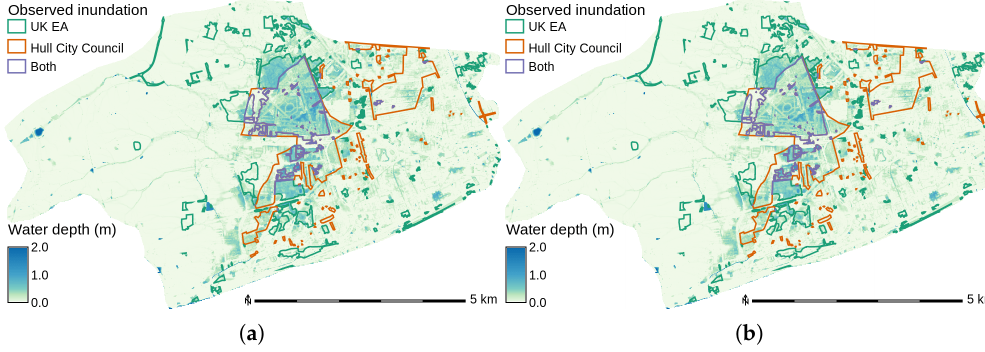
Figure 10. Comparison between observed extents and maximal computed water depths. ( a ) Uniform rainfall; ( b ) Kriging with External Drift.